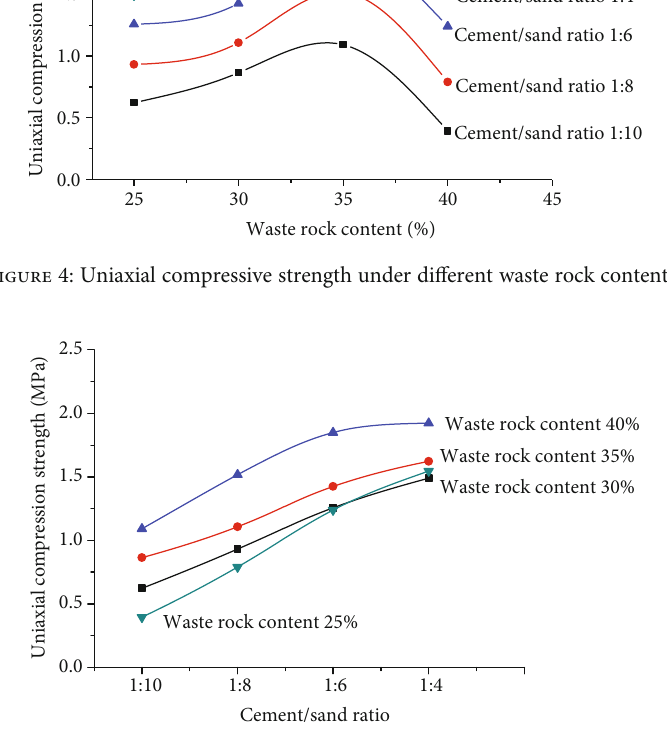
Figure 5: Uniaxial compressive strength under di ff erent cement/sand